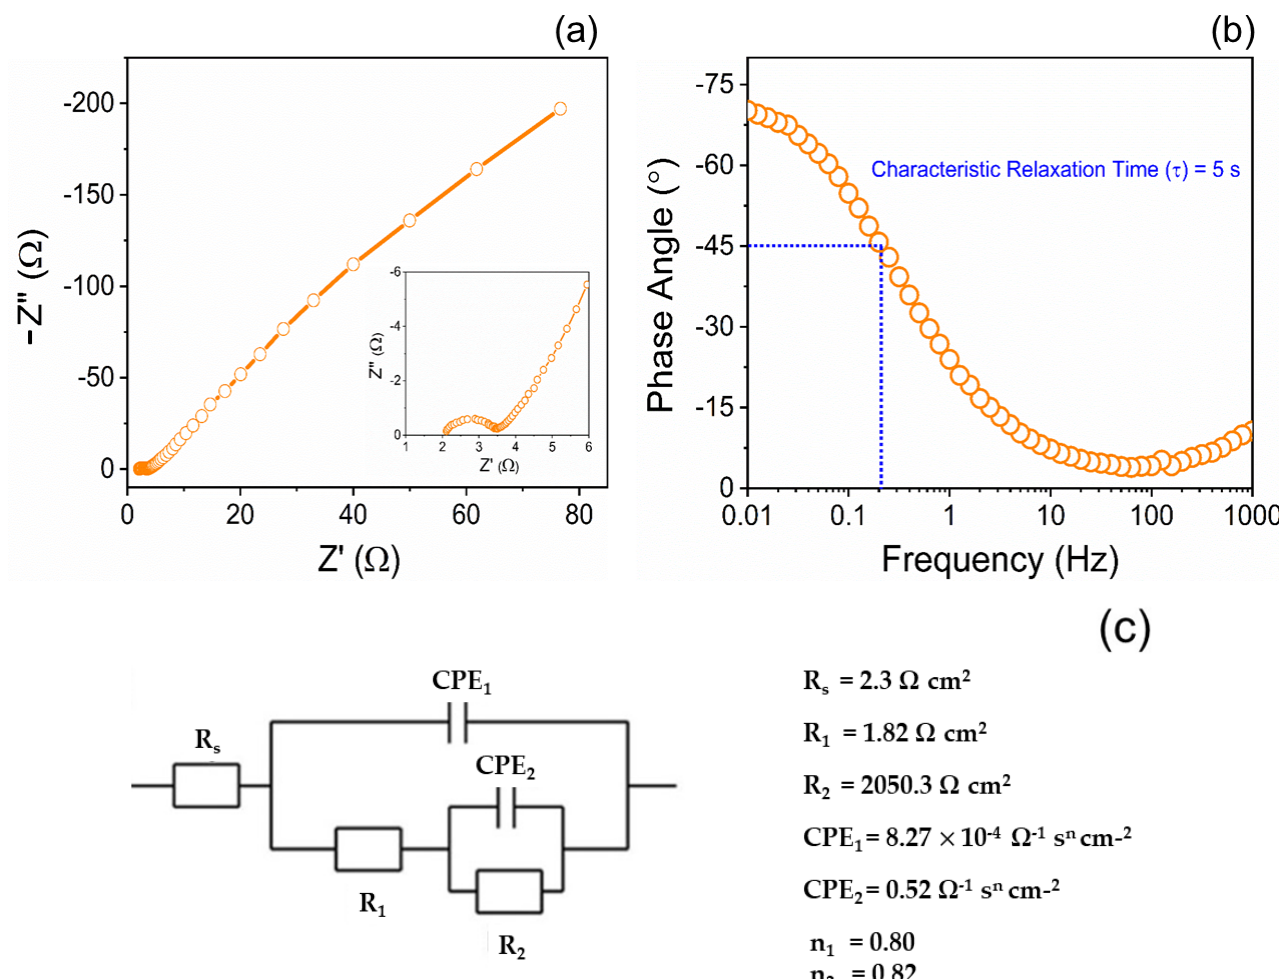
Figure 5. ( a ) EIS Nyquist plot. ( b ) Bode plot depicting the materials response time (characteristic relaxation time). ( c ) The equivalent electrical circuit to fit the impedance data obtained for the semi- polycrystalline polyaniline and the calculated circuit